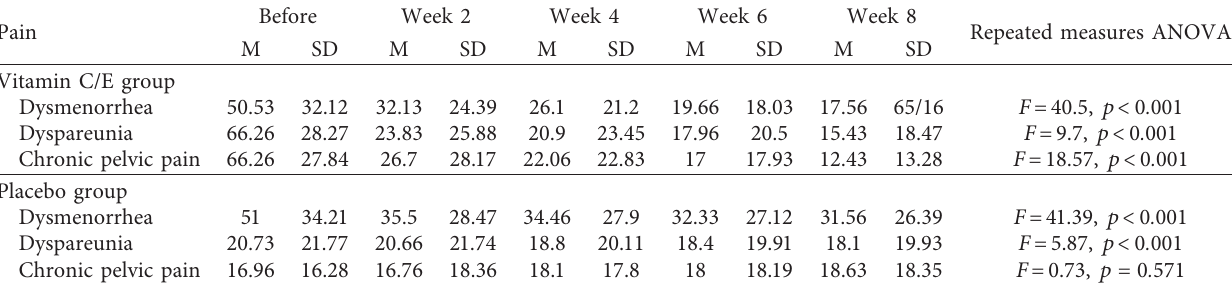
Table 3: Pain intensity score (dysmenorrhea, dyspareunia, and chronic pelvis pain) before and after treatment in the vitamin C/E group. Before Pain Vitamin C/E group